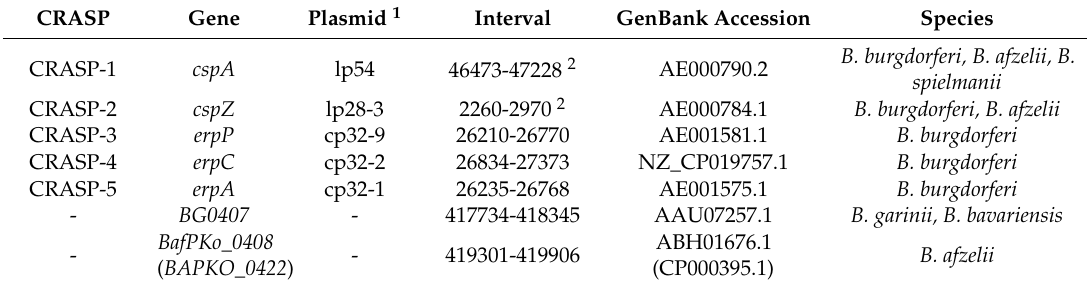
Table 2. Complement-regulator acquiring surface proteins (CRASPs) and related FH-binding proteins, gene names, plasmid replicons, base pair intervals and the species in which they occur. The acronym